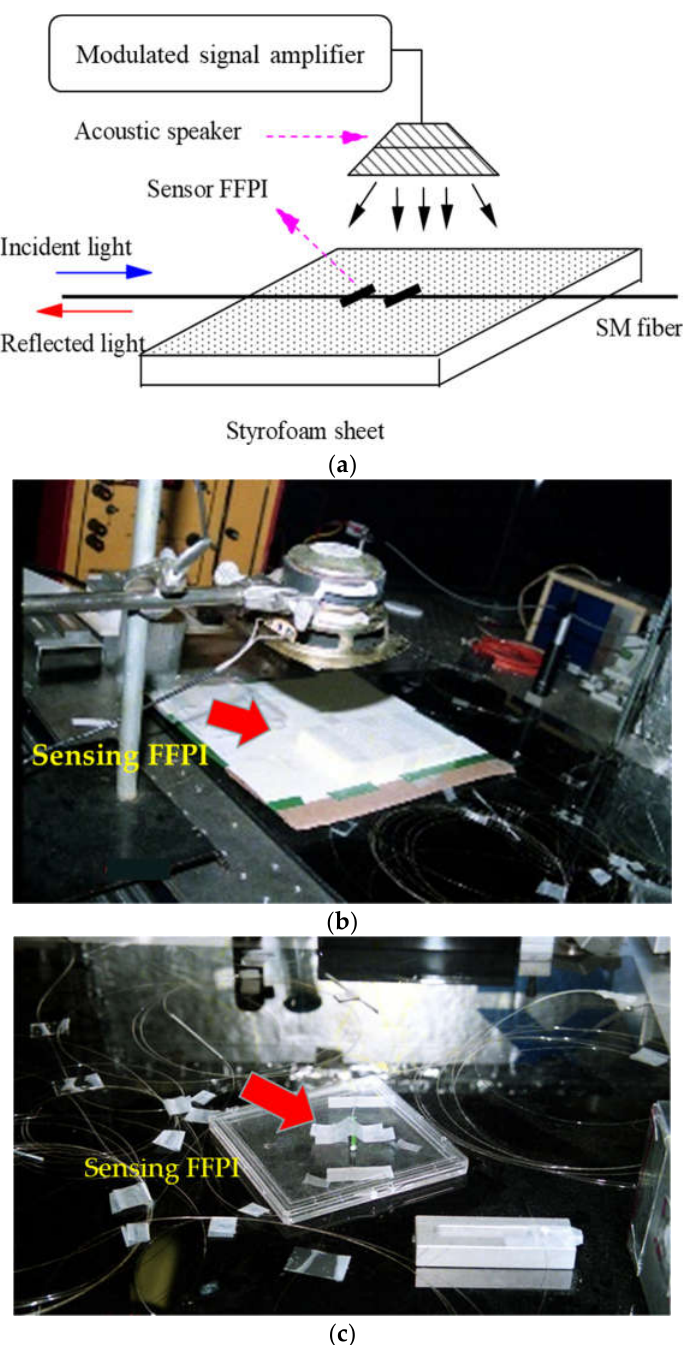
Figure 5. Experimental arrangement to test the acoustic response of sensors with an acoustic speaker, a sensor FFPI, and a Styrofoam sheet: ( a ) schematic illustration, ( b ) physical setup, and ( c ) sensing FFPI outside the acoustic setup.